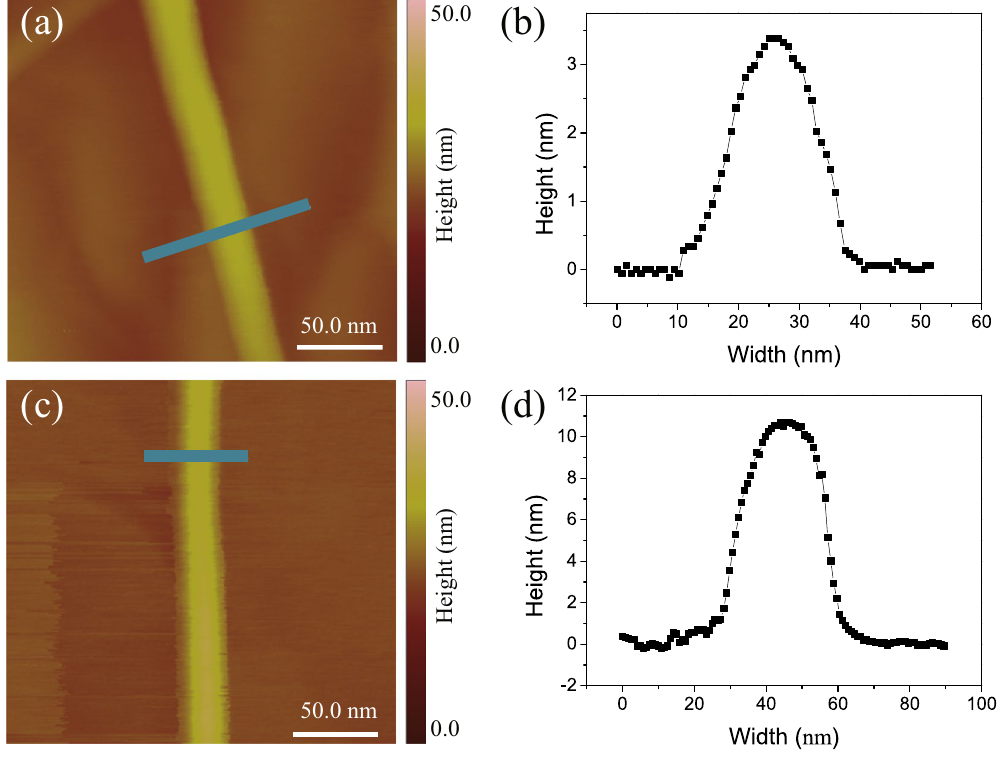
Figure 1. Experimental AFM morphology image of graphene wrinkles on copper sustrate by using super-sharp and high resolution tips. ( a , c ) AFM morphology image of graphene wrinkles obtained by CVD methods. ( b , d ) The AFM heights of the cross-sectionl trace of the line marked in Fig. 1a and c